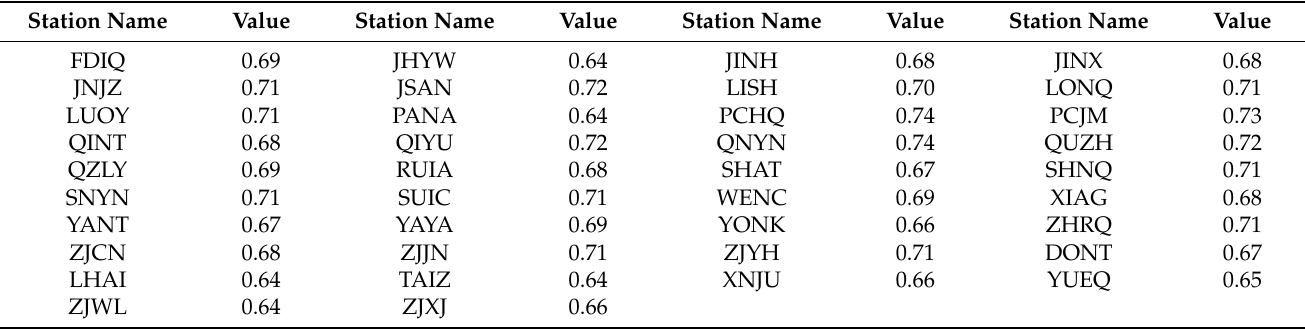
Table 4. Correlation coefficient of temporal results of the CORS network and GRACE, with correction of phase delay.